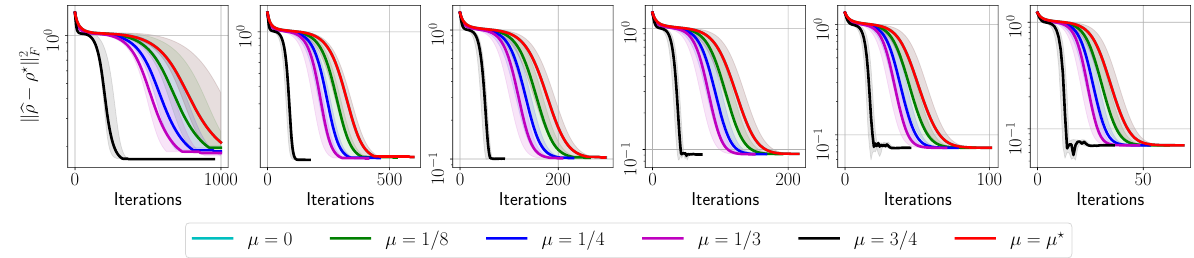
( 8 ) circuit using synthetic measurements −